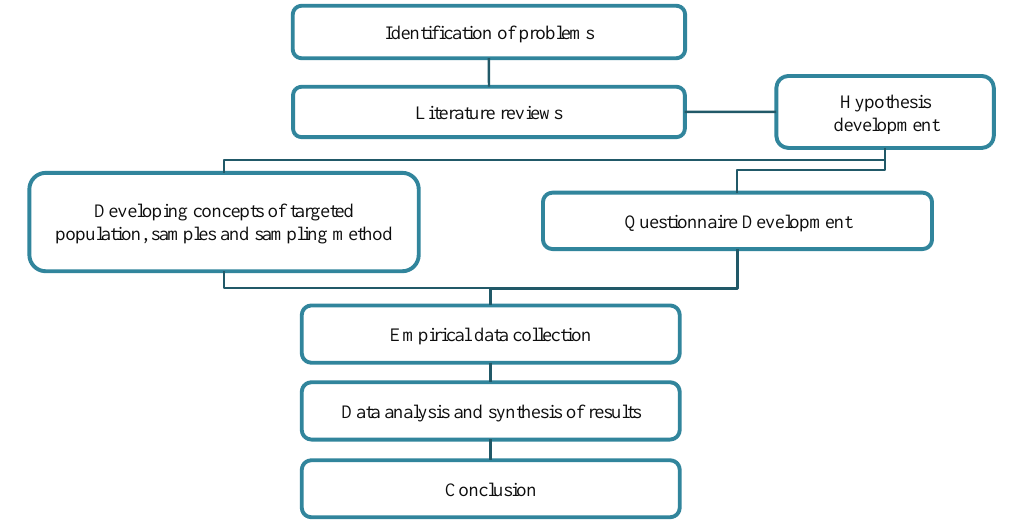
Figure 2. Flowchart of the research